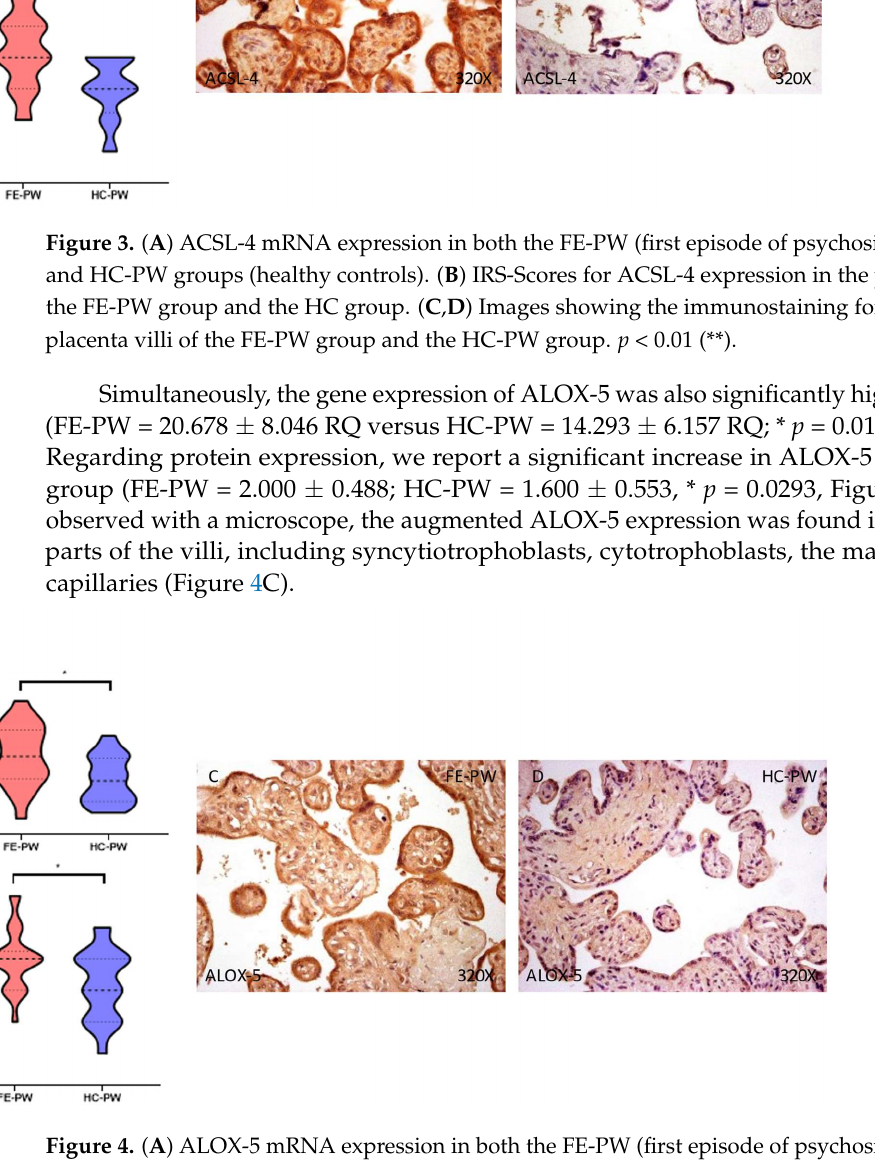
Figure 4. ( A ) ALOX-5 mRNA expression in both the FE-PW (first episode of psychosis in pregnancy) and HC-PW groups (healthy controls). ( B ) IRS-Scores for ALOX-5 expression in the placenta villi of the FE-PW group and the HC group. ( C , D ) Images showing the immunostaining for ALOX-5 in the placenta villi of the FE-PW group and the HC-PW group. p < 0.05 (*). Finally, the levels of MDA in the placentas of the FE-PW group were significantly higher than those found in the HC group (FE-PW = 122.965 ± 34.259 pmol/mg; HC-PW = 81.821 ± 30.026 pmol/mg, *** p < 0.001, Figure 5). Figure 5. Malondialdehyde (MDA) levels, in pmol/mg, found in the placental tissues of both the FE- PW and HC-PW groups. FE-PW = first psychotic episode during pregnancy. HC-PW = healthy con- trols pregnant women. p < 0.001 (***).